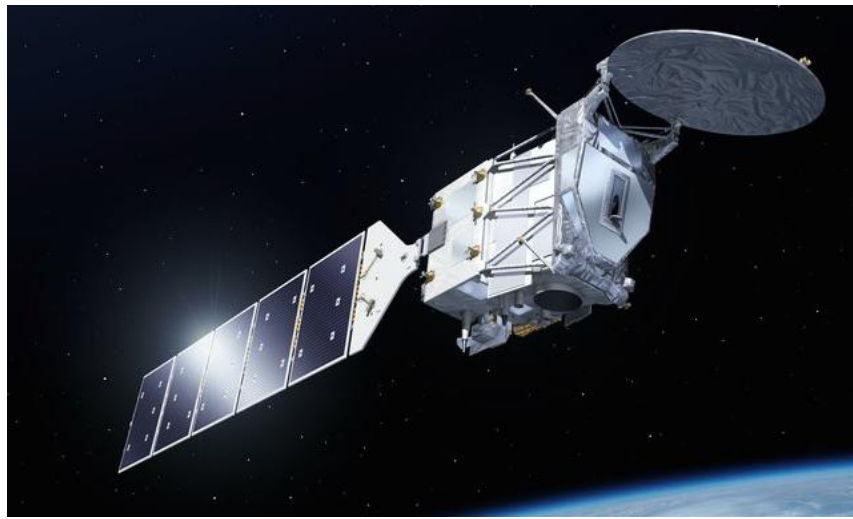
Figure 1. Artist’s view of the EarthCARE satellite in-orbit. Reproduced with permission of European Space Agency.